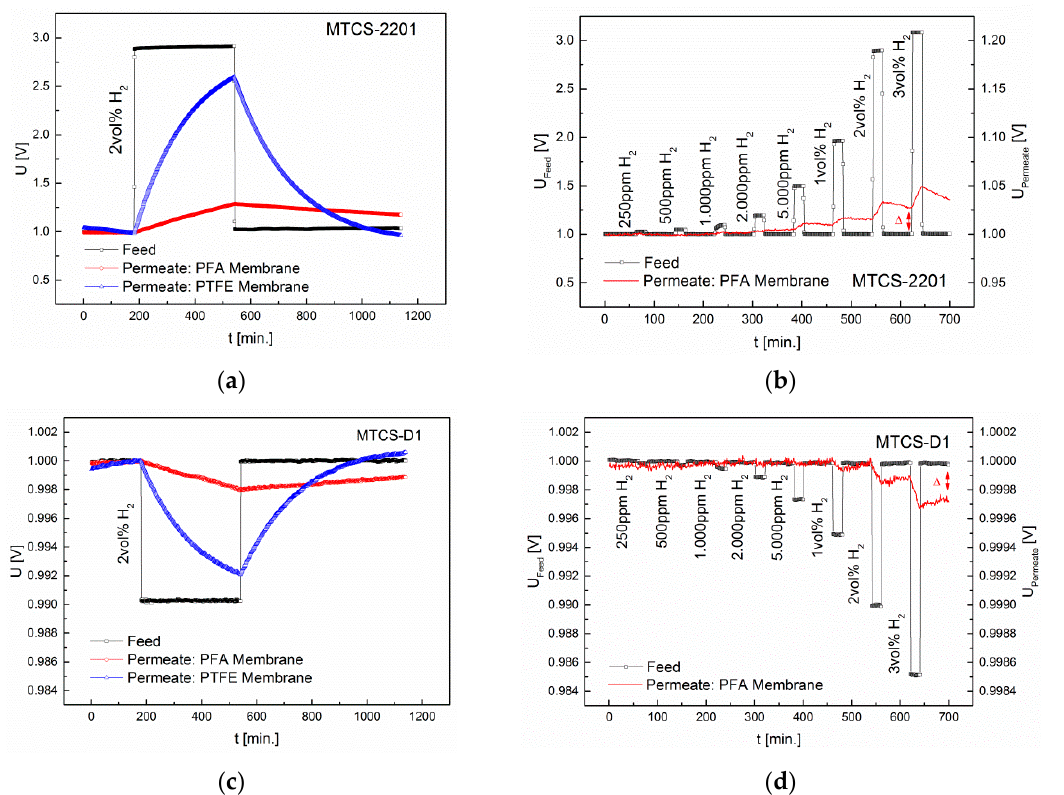
Figure 9. Interdependence of diffusion and sensor signal, measured with the TC sensors. ( a ) Sensorgram of the MTCS-2201 sensor (pulsed operation) in the permeate and feed during 6 h exposure to 2 vol% H 2 using PFA and PTFE membranes; ( b ) Sensorgram of the MTCS-2201 sensor (pulsed operation) during exposure to 1–250 ppm H 2 using the PFA membrane; ( c ) Sensorgram of the MTCS-D1 sensor (isothermal operation) in the permeate and feed during 6 h exposure to 2 vol% H 2 using PFA and PTFE membranes; ( d ) Sensorgram of the MTCS-D1 sensor (isothermal operation) during exposure to 1–250 ppm H 2 using the PFA membrane.